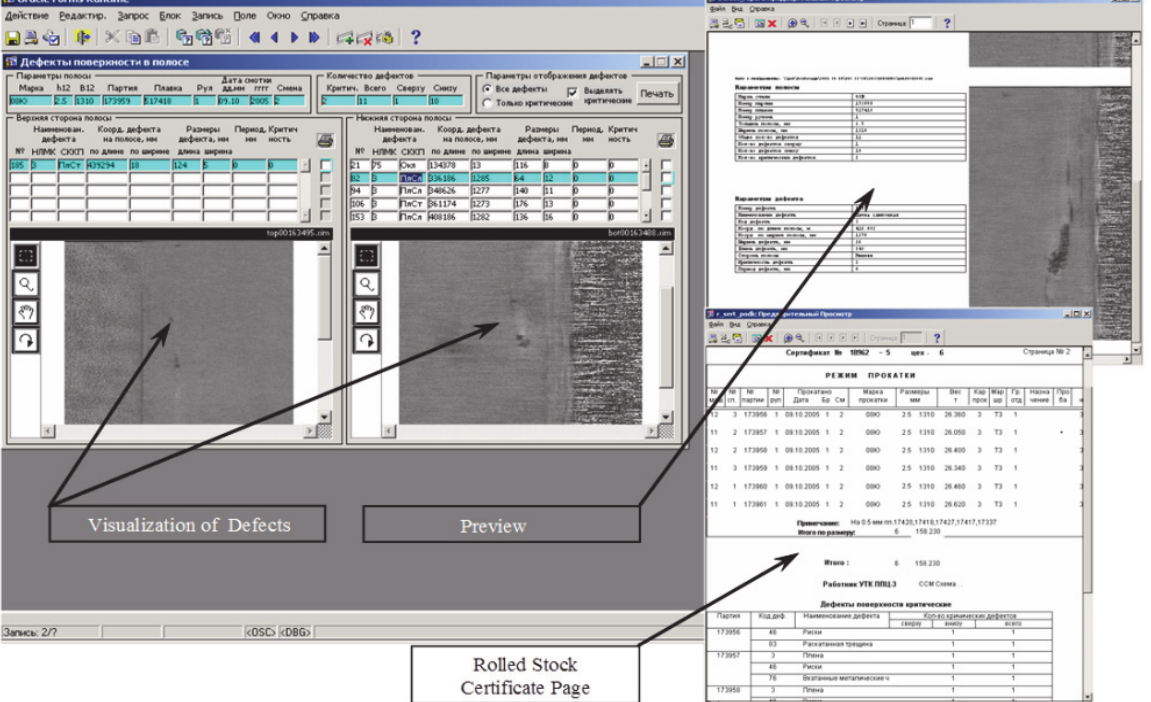
Figure 3: Visualization of application for the certification of hot rolled rolls